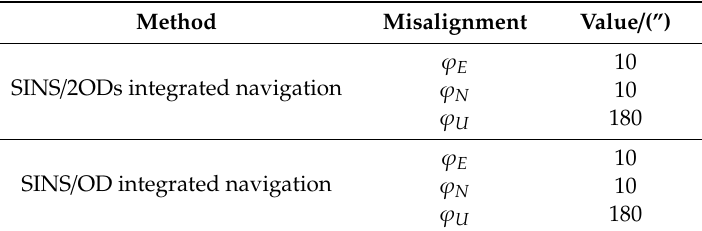
Table 2. Initial misalignment